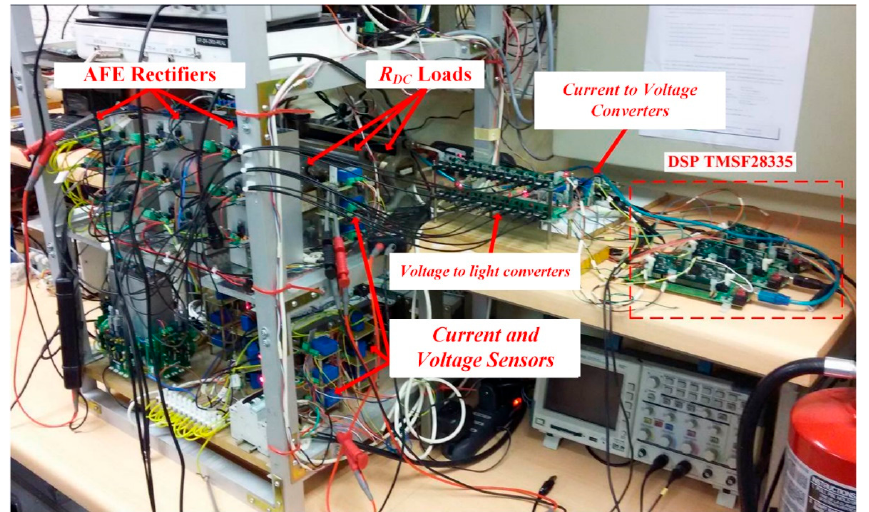
Figure 6. Experimental setup.